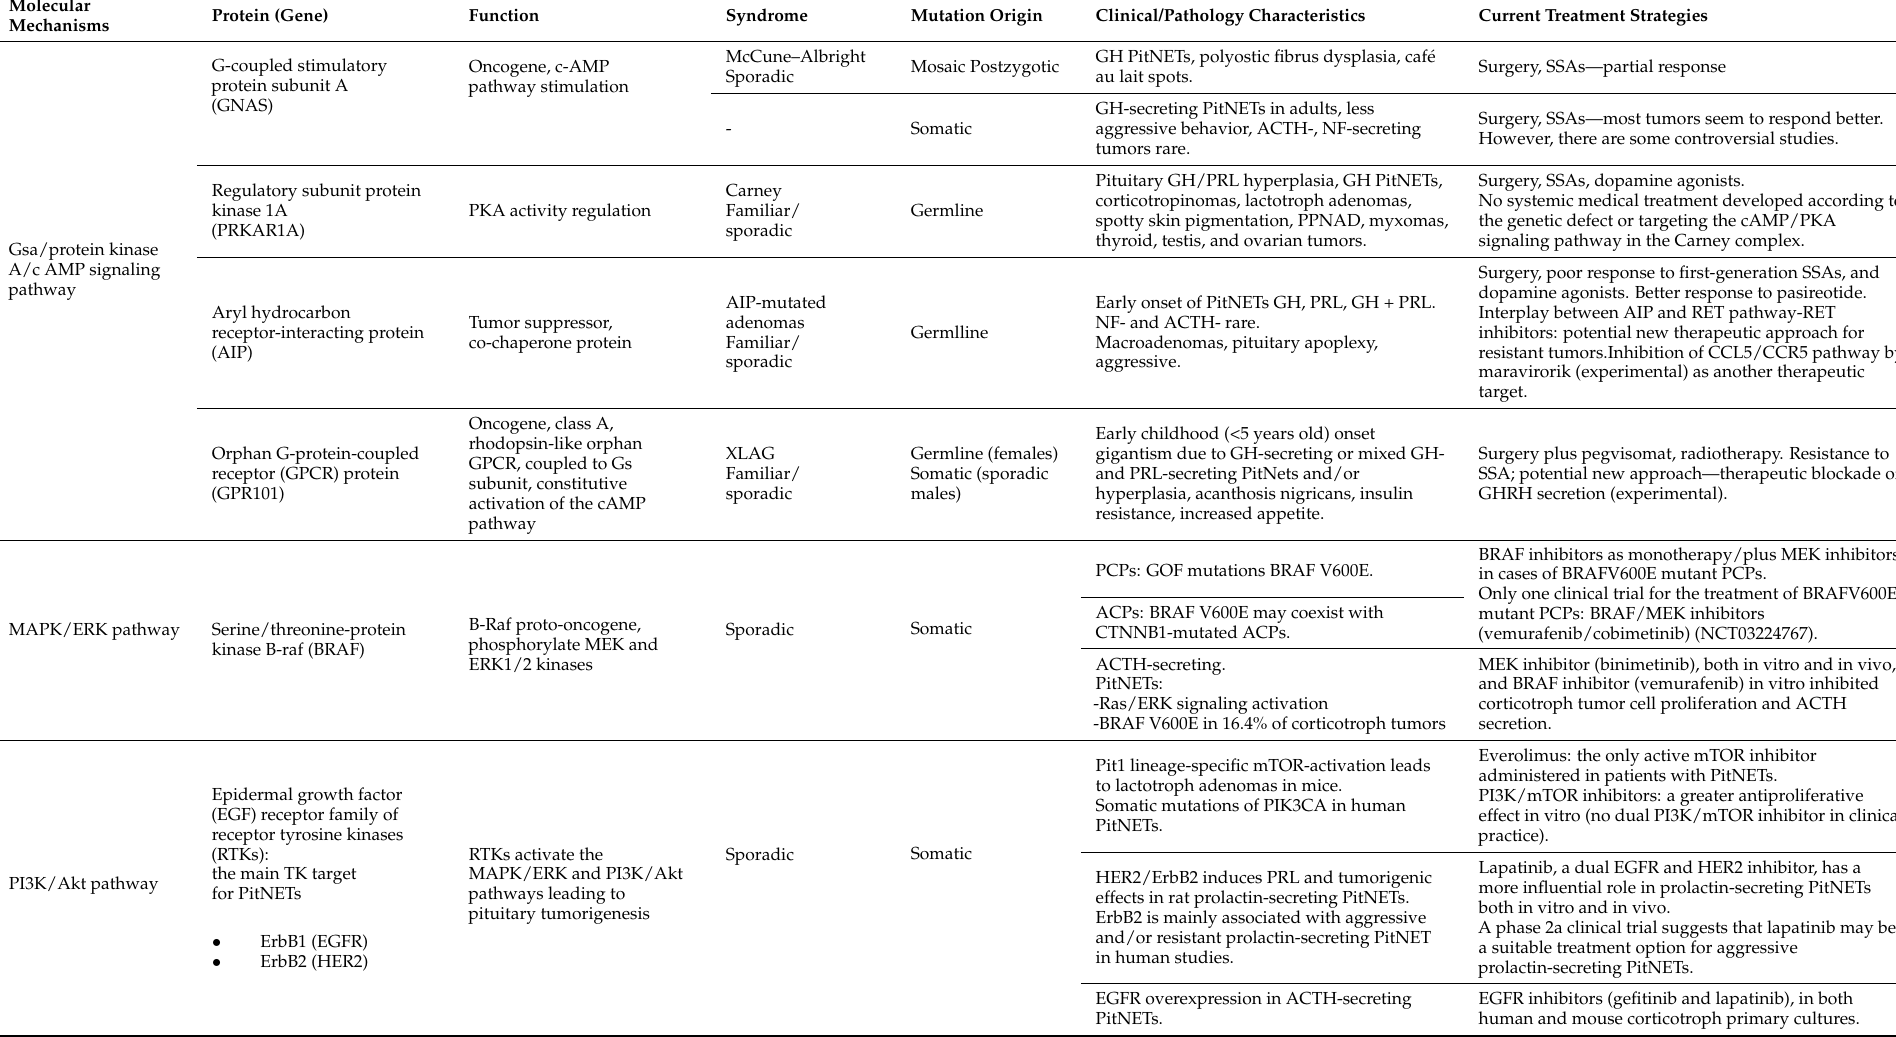
Table 1. Molecular pathways and genes involved in the pathogenesis of the